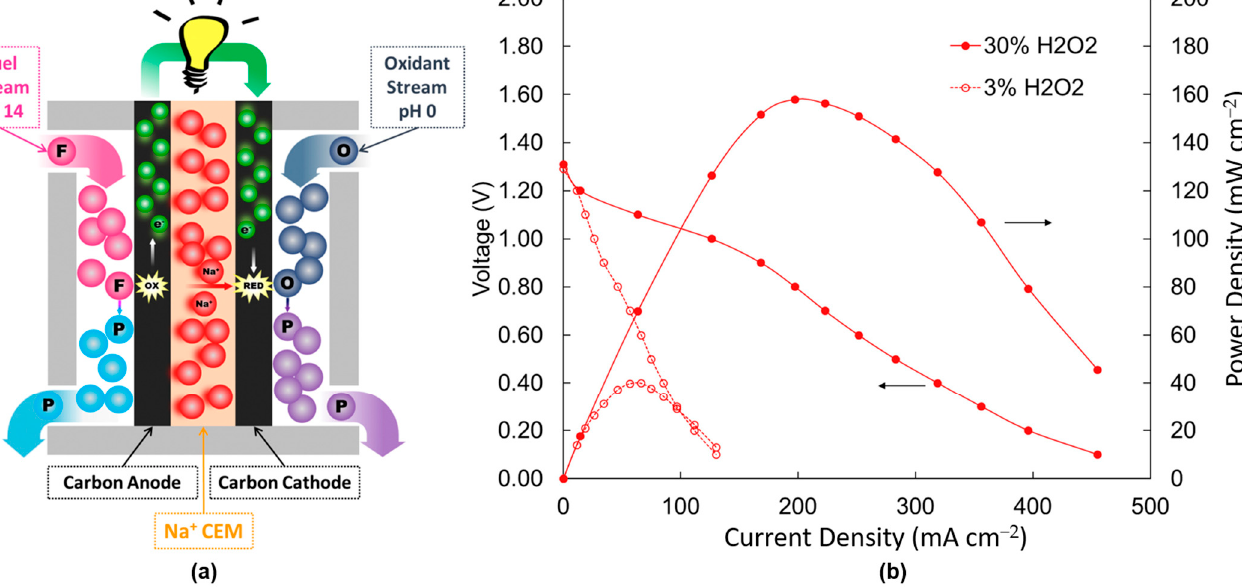
Figure 5. ( a ) Working principle of the split-pH DAAFC, ( b ) VI plots of the split-pH DAAFC with anode fuel 1 M ascorbate + 1 M NaOH (pH 14) and cathode oxidant is 3 or 30% H 2 O 2 + 1 M H 2 SO 4 (pH 0). Reproduced with permission [41]. Copyright 2018 Elsevier B.V. The reported AA ‐ based fuel cells are all listed in Table 1. The order is based on the highest performance.